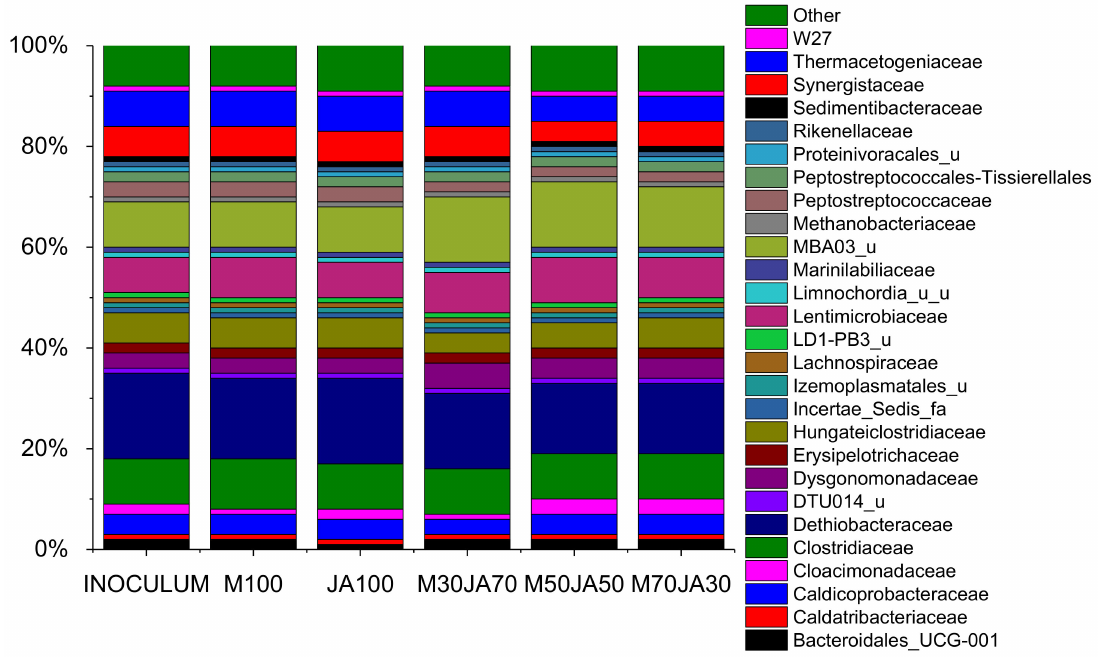
Figure 3. Silage samples bacterial and archaeal 16S rRNA genes relative abundance at family level, based on the average ASV reads from triplicates. Sampled on Day 35, except inoculum, which was sampled on day 0.